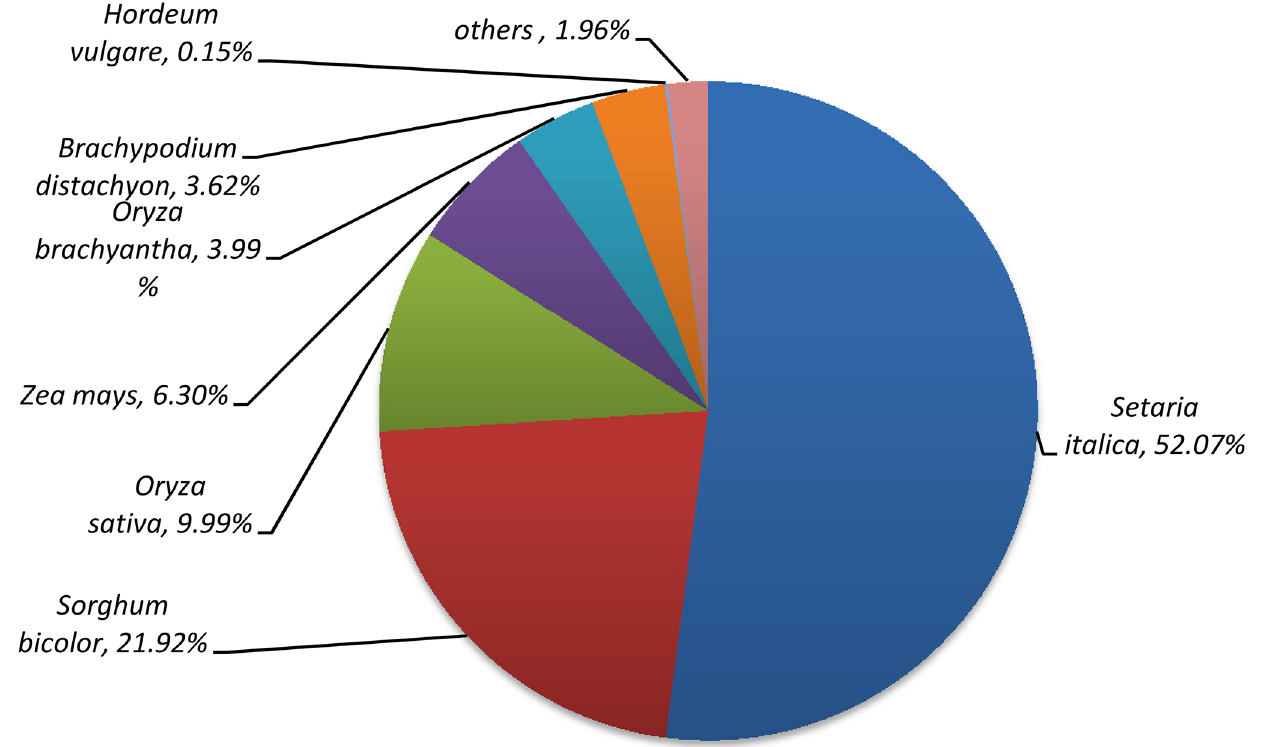
Fig 4. Species distribution of the BLAST